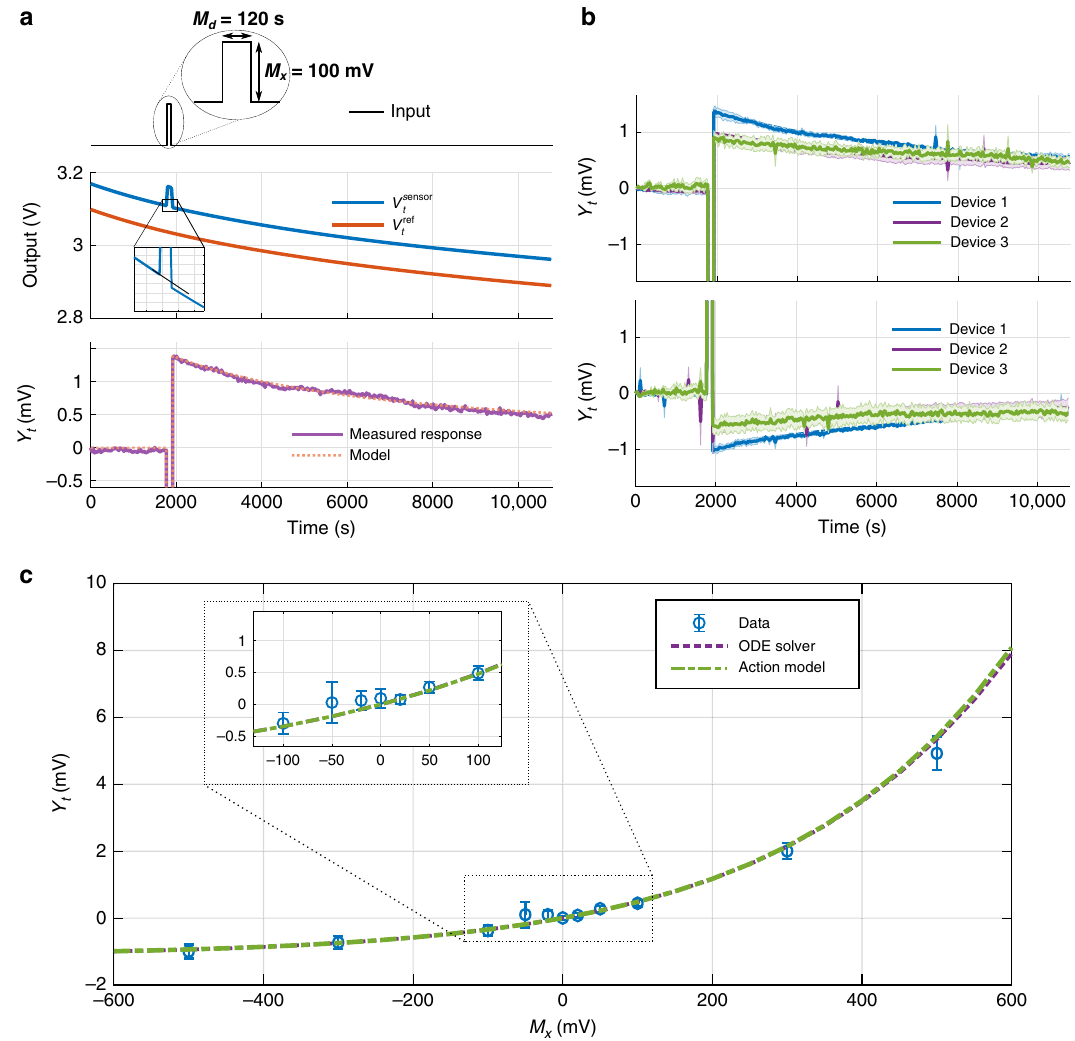
Fig. 3 Rectifying response of the sensor-data-logger device. a Output measured from the device when subjected to an input pulse. During the positive half of the input pulse, the tunneling rate increases and desynchronizes the sensor device with respect to the reference device. b Responses measured from three loggers across three trials. The loggers were initialized to different conditions, hence the difference in their measured responses. c Sensor responses for input signals over a range of amplitudes. Responses follow an exponential model, which can be accurately modeled by the action model and an ODE